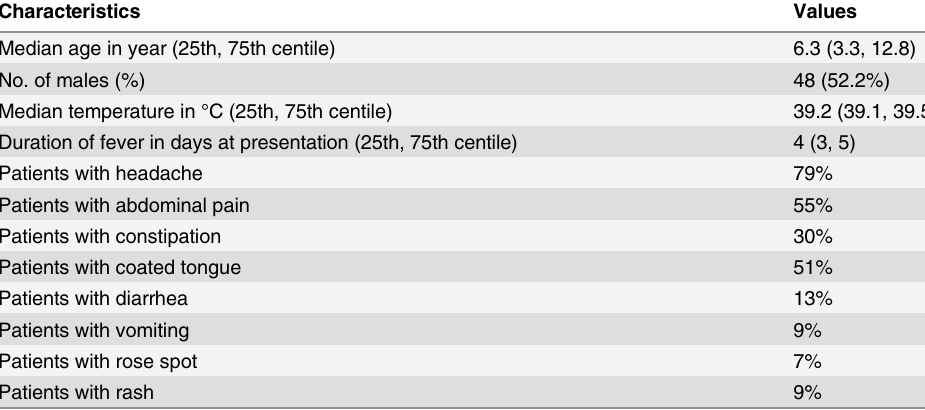
Table 1. Characteristics of the patients with signs and symptoms of typhoid fever (n = 92).